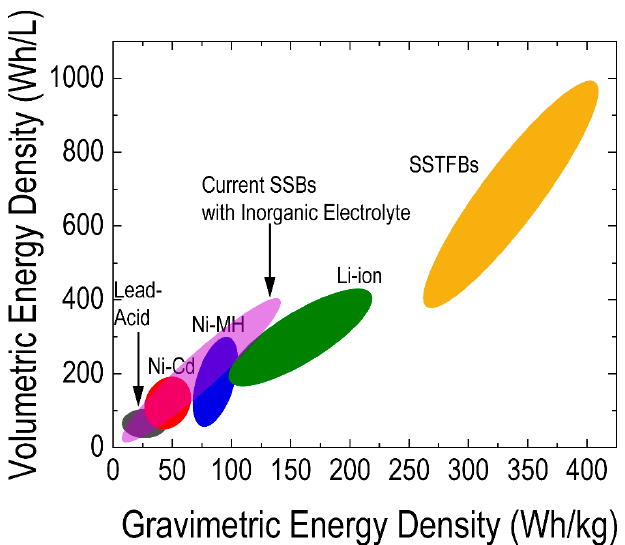
Figure 11. Comparison of the volumetric and gravimetric energy density of solid-state thin-film batteries (SSTFBs) with other batteries [333–335].